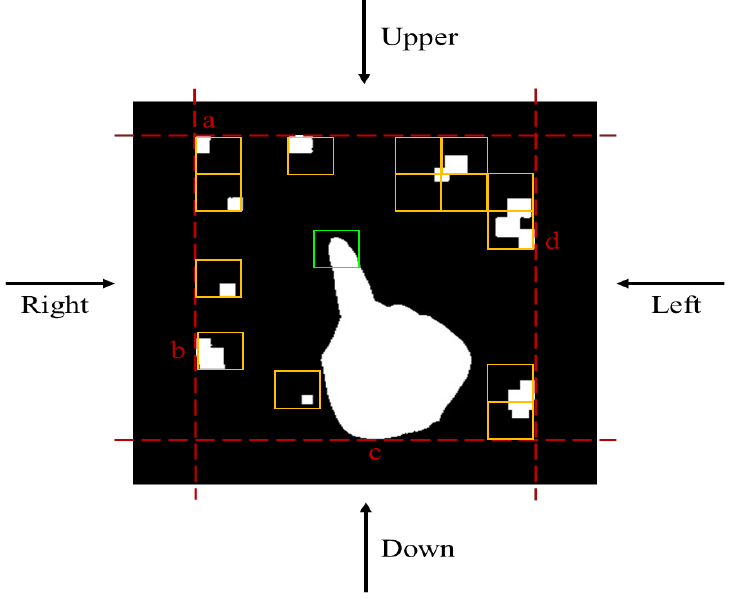
Figure 6. The variation scope of the moving objects.